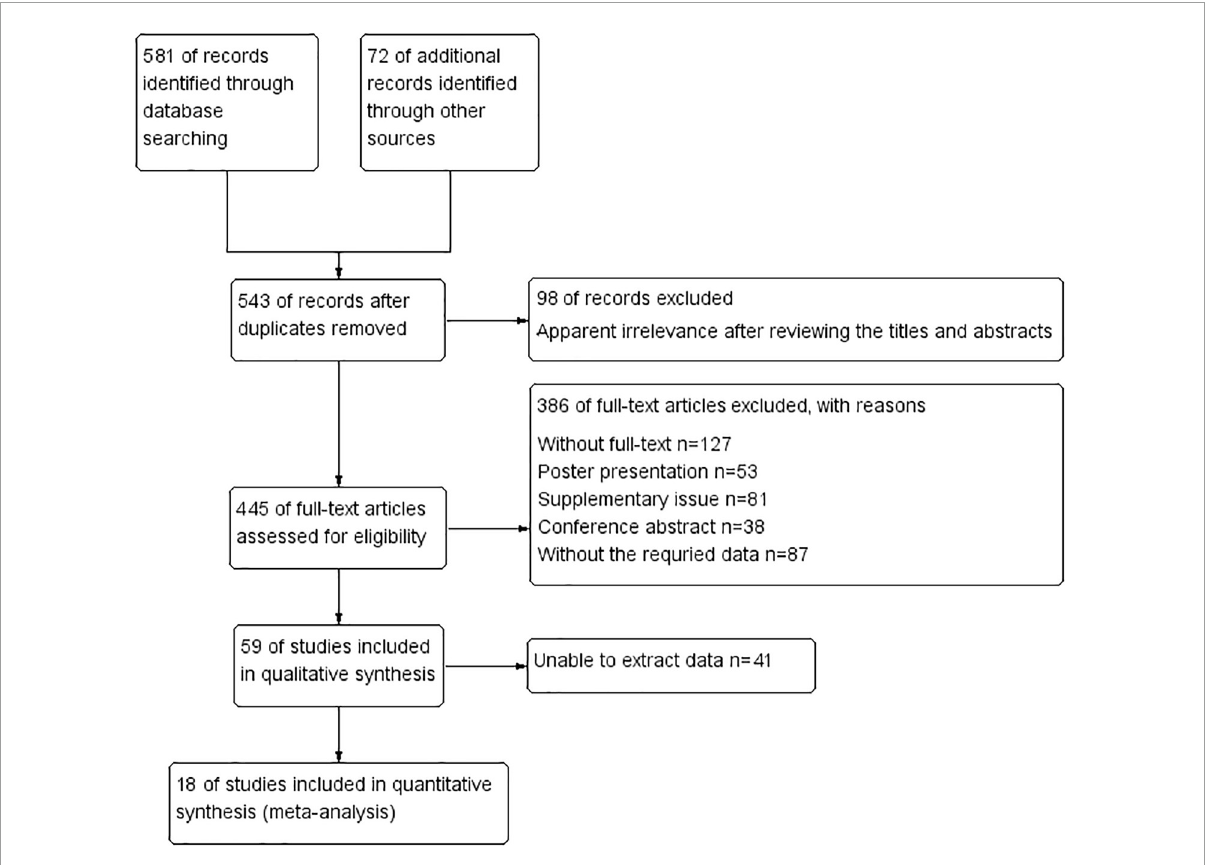
FIGURE1 Selection process of the included studies in the